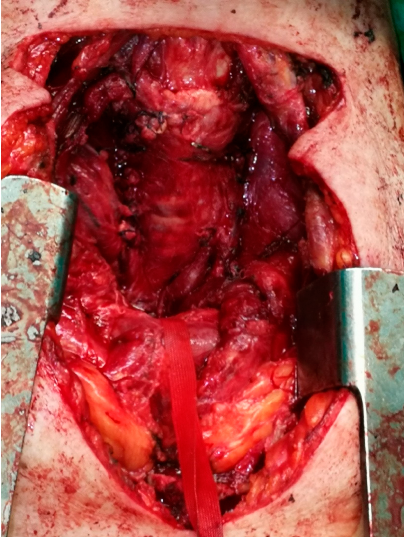
Figure 5. The residual cavity after the surgical removal of the substernal goiter.